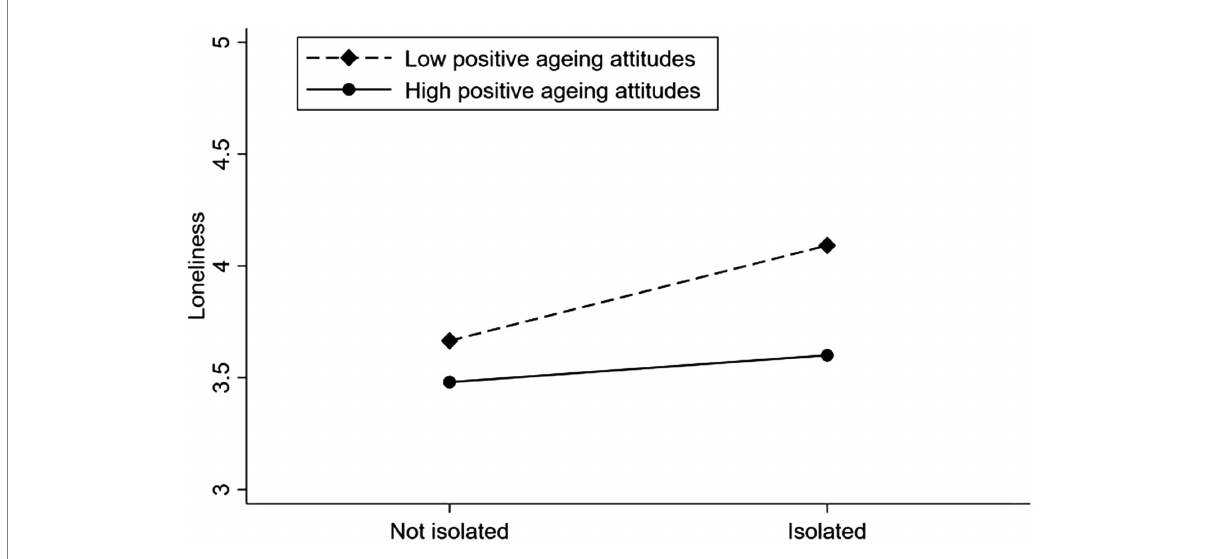
FIGURE 3 Loneliness among older adults who were not socially isolated or isolated with different levels of positive aging attitudes.